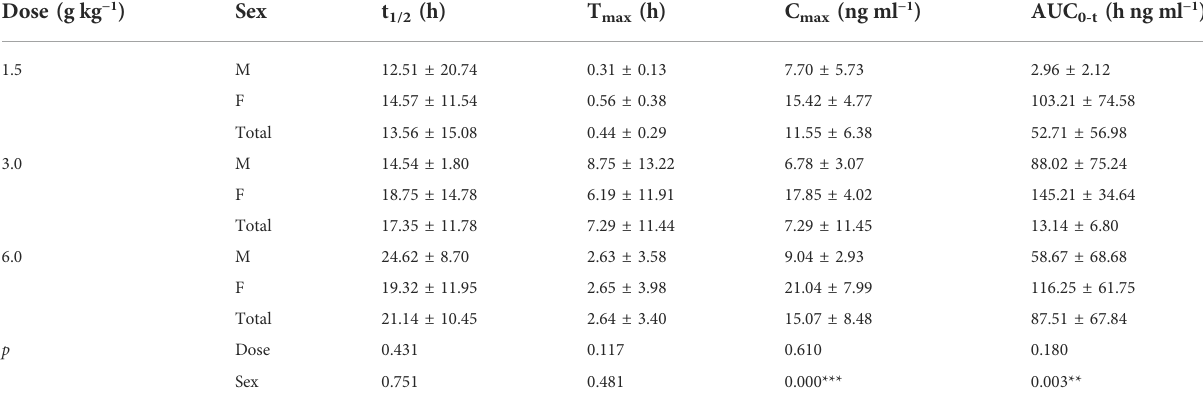
TABLE 12 Pharmacokinetic parameters of ferulic acid after different doses of TYZB in rats (D30). Dose (g kg − 1 ) Sex t 1/2 (h) T max (h) C max (ng ml − 1